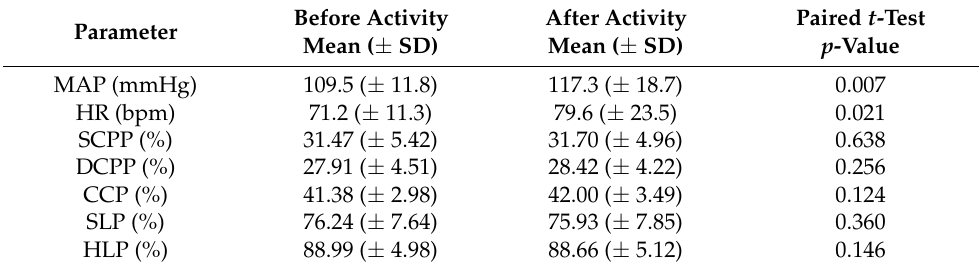
Before Activity Mean ( ± SD)